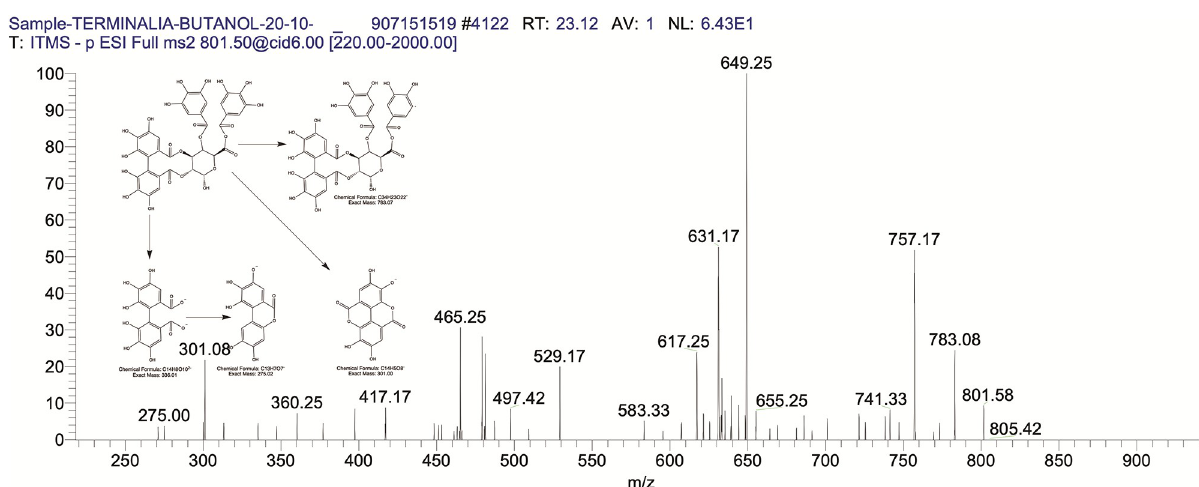
Fig 9. The mass spectrum of digalloyl-HHDP-glucuronide and its fragmentation pattern.